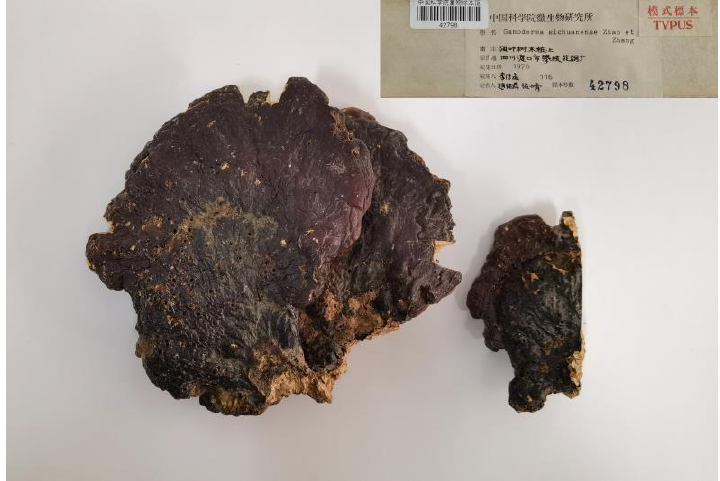
Figure 4. The holotype of Ganoderma sichuanense (HMAS 42798).